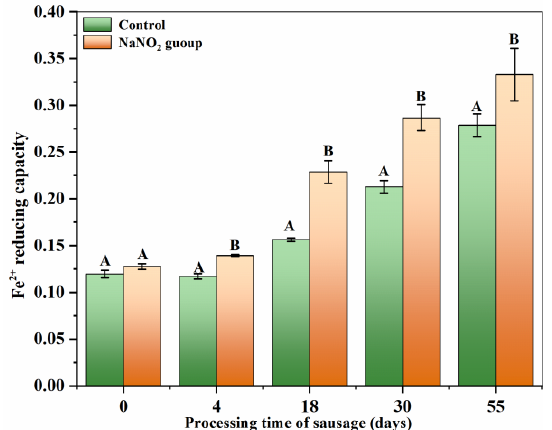
Figure 4. Changes in the iron-chelating activity of polypeptides during sausage processing. Differ- ent uppercase letters in the columns indicate significant differences among treatments during storage time (days) for each treatment ( p < 0.05).